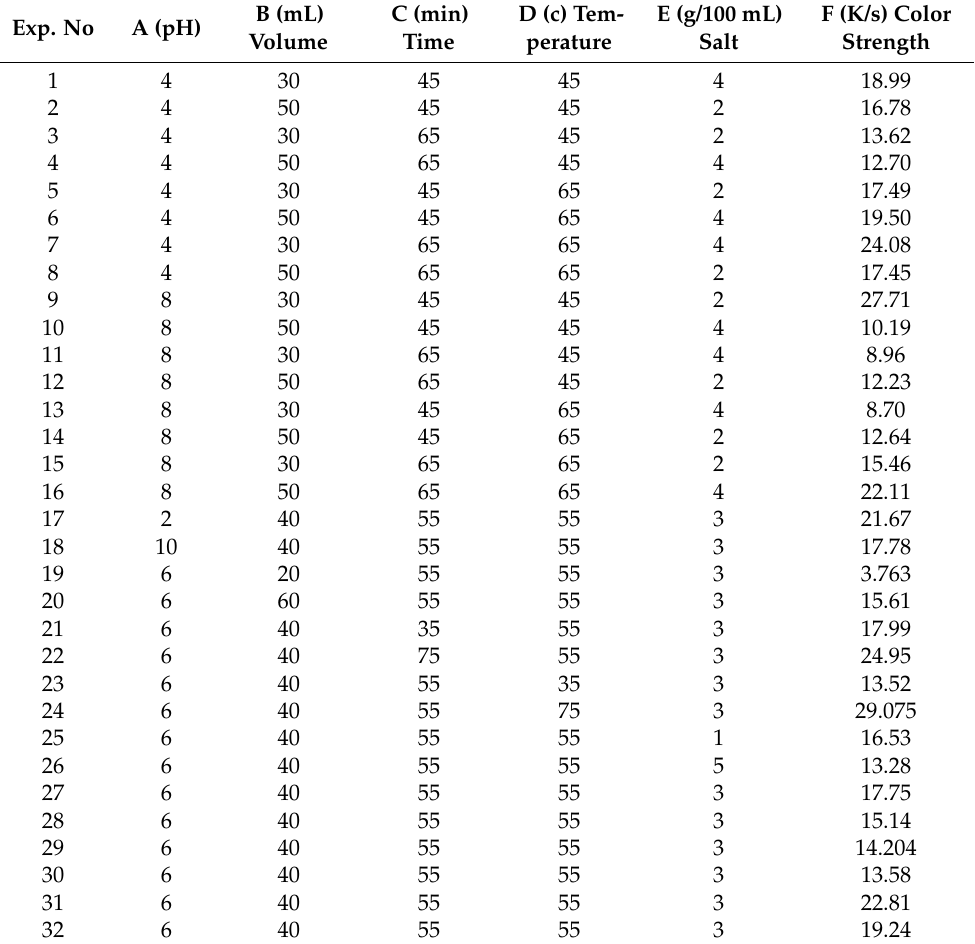
Table 2. Central composite design for optimization of dyeing variables using irradiated extract of red